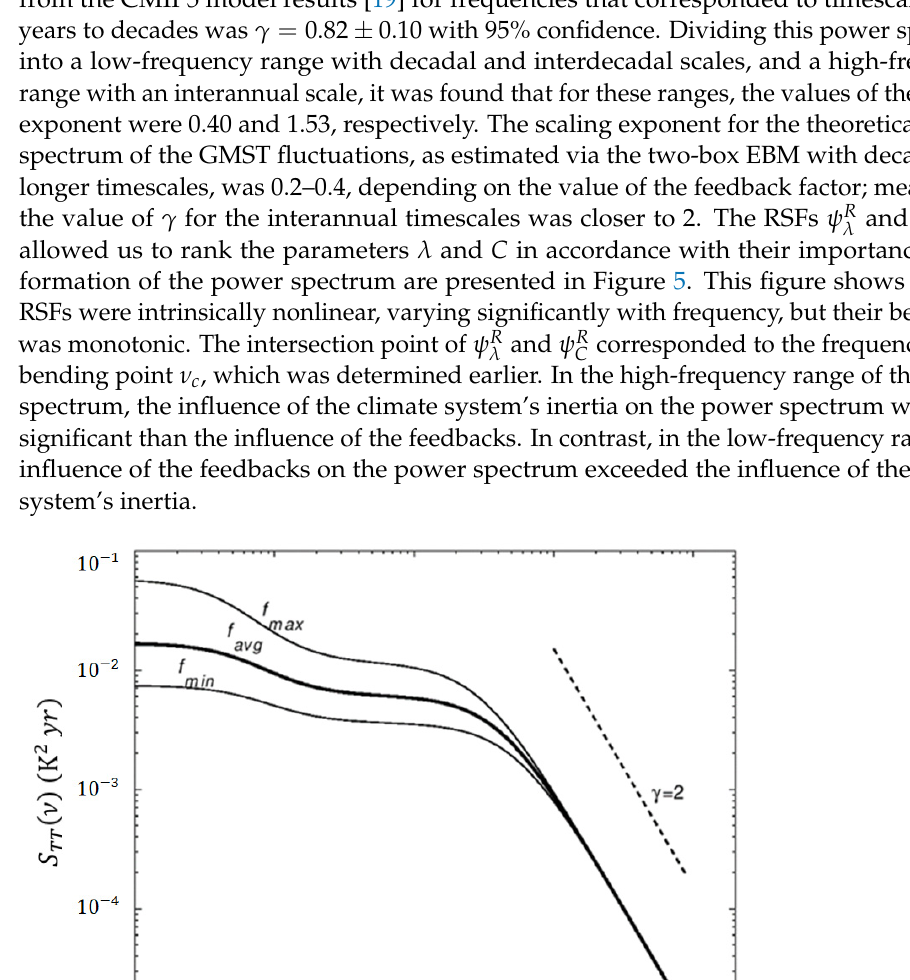
Figure 5. Relative sensitivity functions 𝜓 (cid:3090) (cid:3019) and 𝜓 (cid:3004) (cid:3019) , which were calculated for different values of the feedback coefficient 𝑓 .